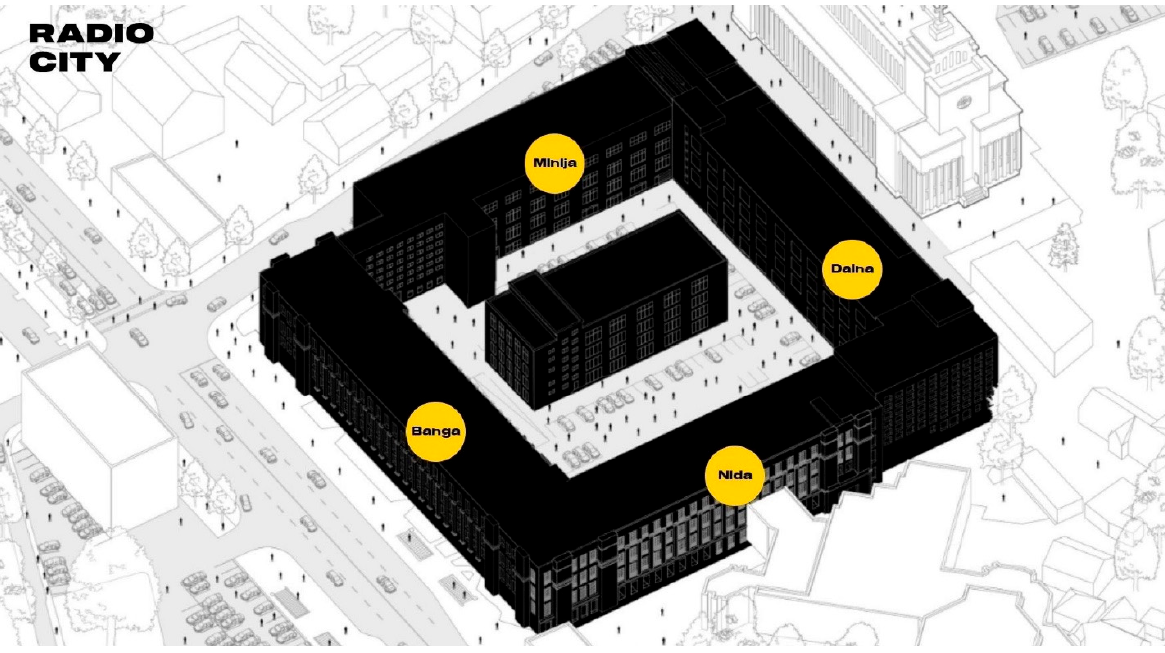
Figure 20. Massing diagram of “Radio City” (source: UAB Citus).